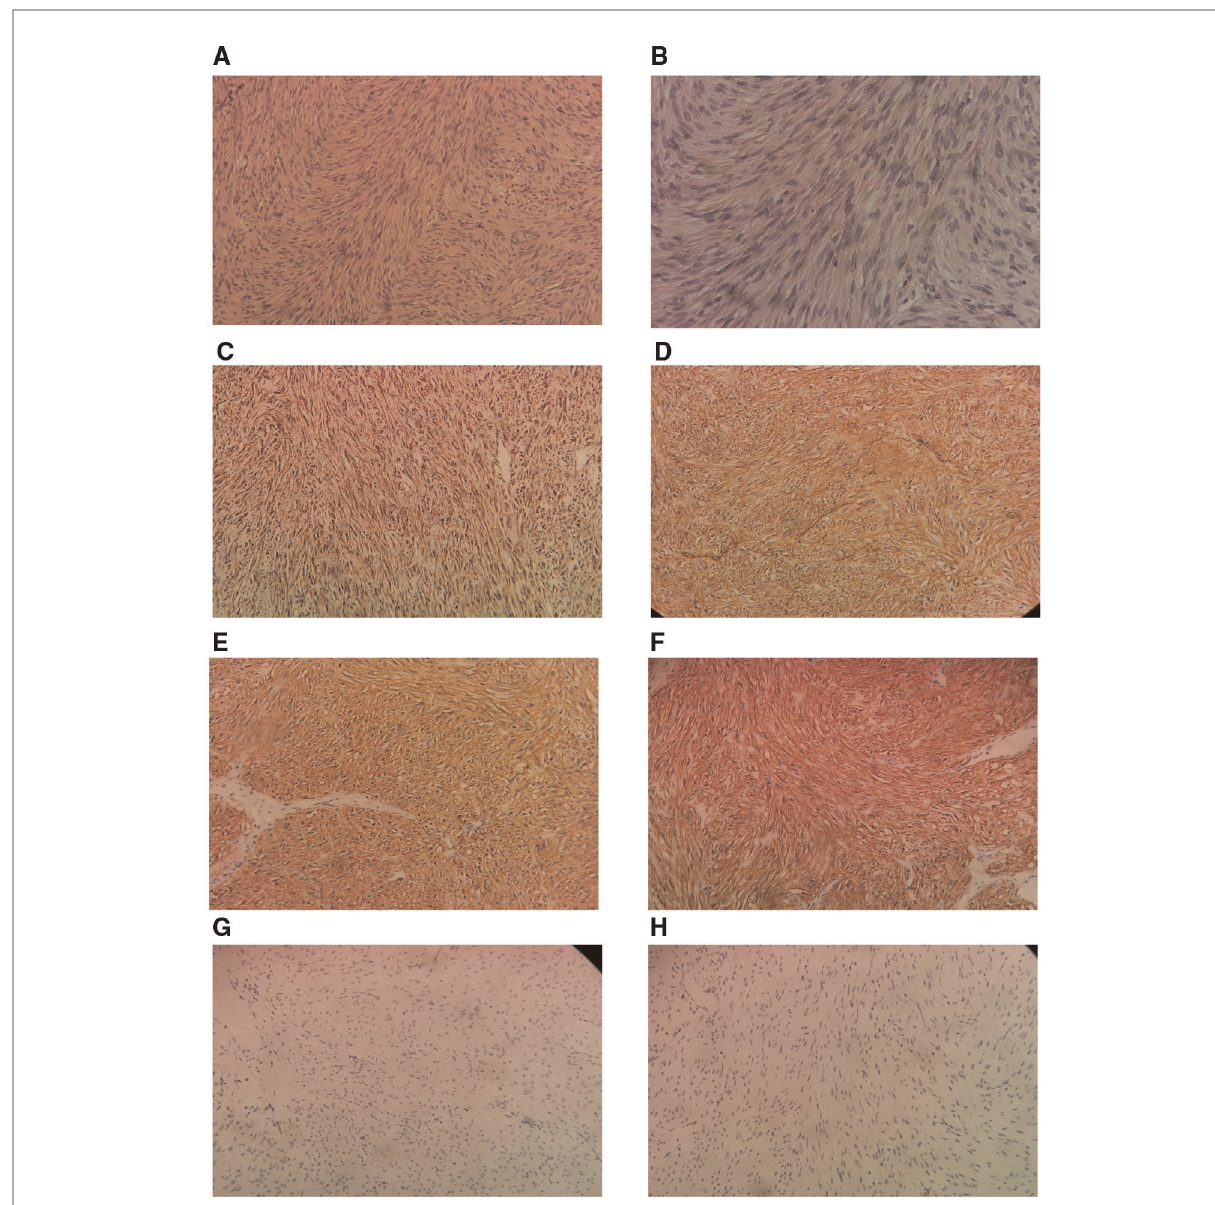
FIGURE 4 Histological sample. ( A ) Low power H & E Showing spindle shaped tumor cells arranged in fascicles and bundles. for tumor ( B ). Higher power view showing the spindle appearance of tumor cells. IHC positivity for SDH-B ( D ). IHC positivity for CD 34 ( E ). IHC positivity for DOG1 ( F ). IHC positivity for CD117 ( G ). IHC negativity for desmin ( H ). IHC negativity for S-100. H & E, hematoxylin and eosin stain; IHC, immunohistochemistry of tumor cells